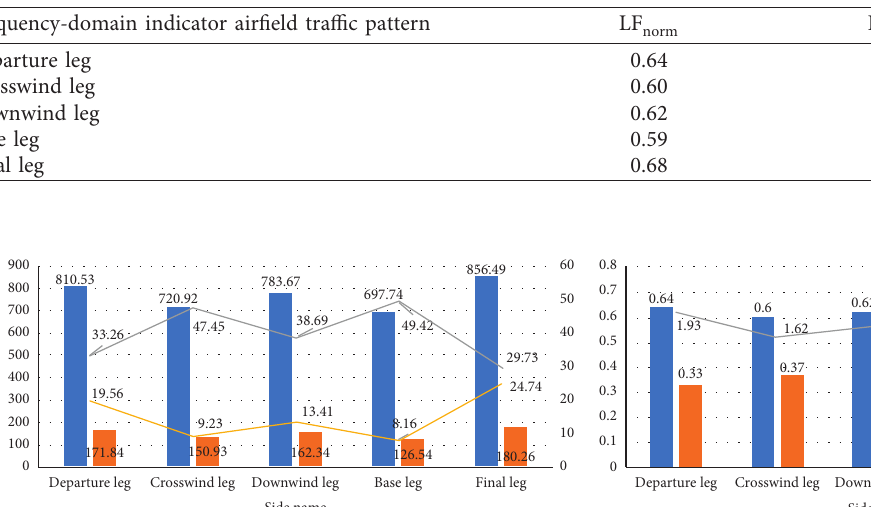
Figure 13: Departure leg ECG power spectrum. Table 5: Results of HRV frequency-domain indicators on each phase of the airfield traffic pattern.